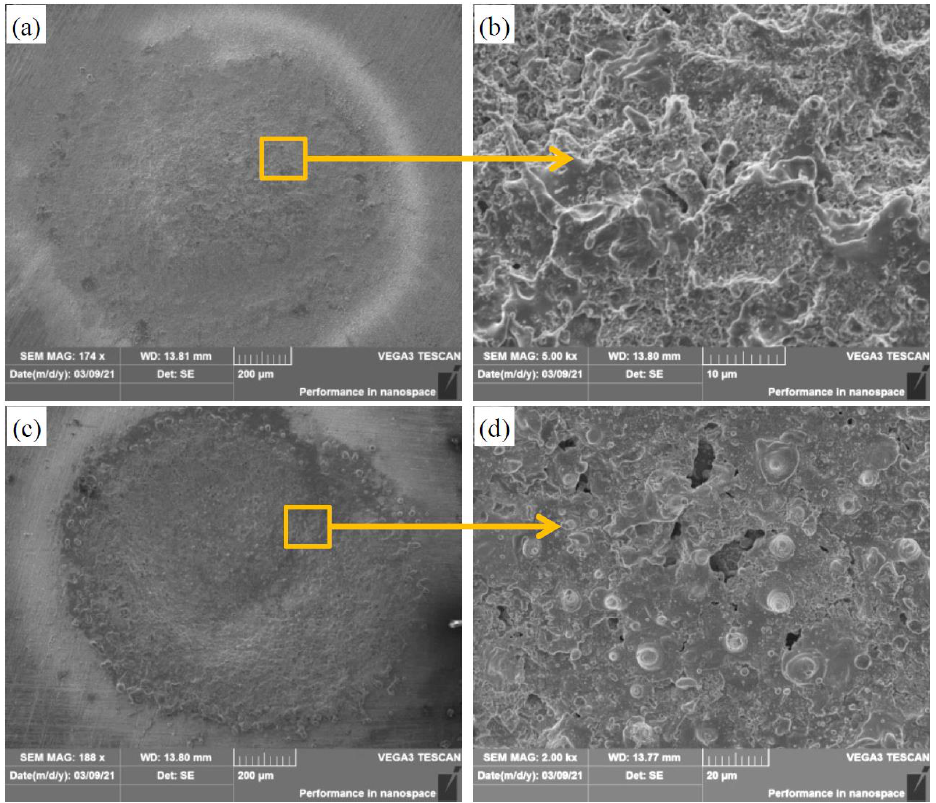
Figure 15. Surface observation of Cu-30 wt% W composite contacts after electrical contact test: ( a ) anode contact; ( b ) enlarged view of ( a ); ( c ) cathode contact; ( d ) enlarged view of ( c ).